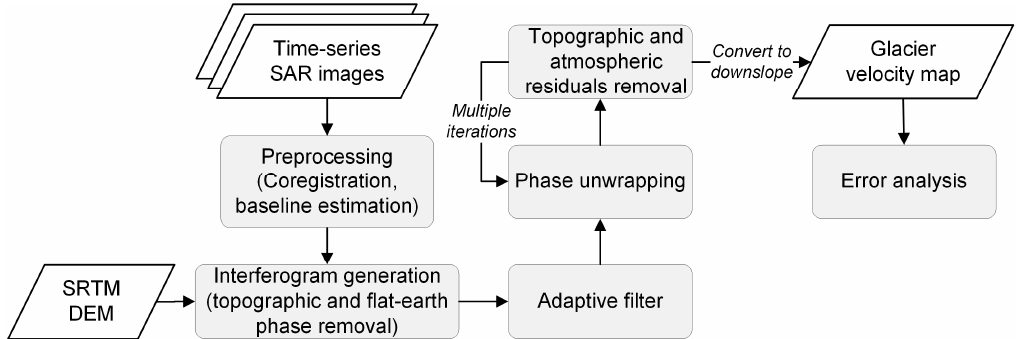
Figure 2. InSAR-based processing steps for the calculation of glacier surface velocities.